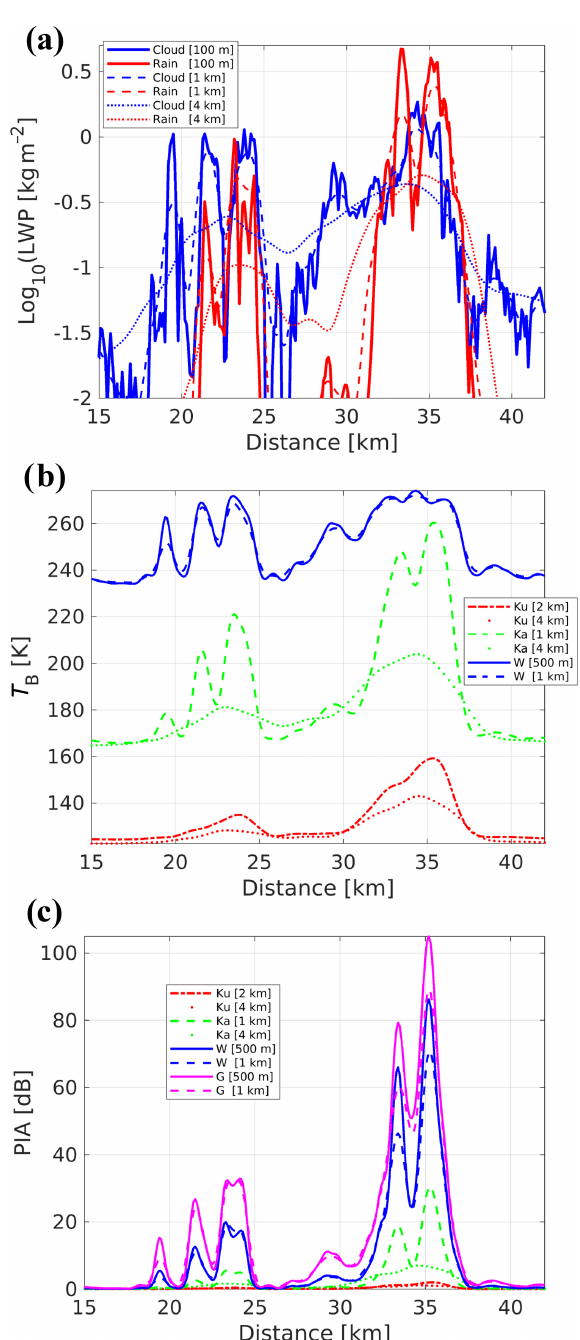
Figure 7. (a) Integrated cloud and liquid water path along the cross section shown in Fig. 5 at the native model resolution and when accounting for different footprint sizes, as indicated in the legend. (b) Brightness temperatures for different frequencies and footprint sizes as indicated in the legend. Random noise with a standard de- viation of 2K is added to the measurements. A nadir-looking ge- ometry is assumed. (c) Two-way hydrometeor PIAs computed sim- ulating SRT (surface reference technique) observations for different frequencies as indicated in the legend. Red, green, blue and magenta correspond to the Ku-, Ka-, W- and G-band,